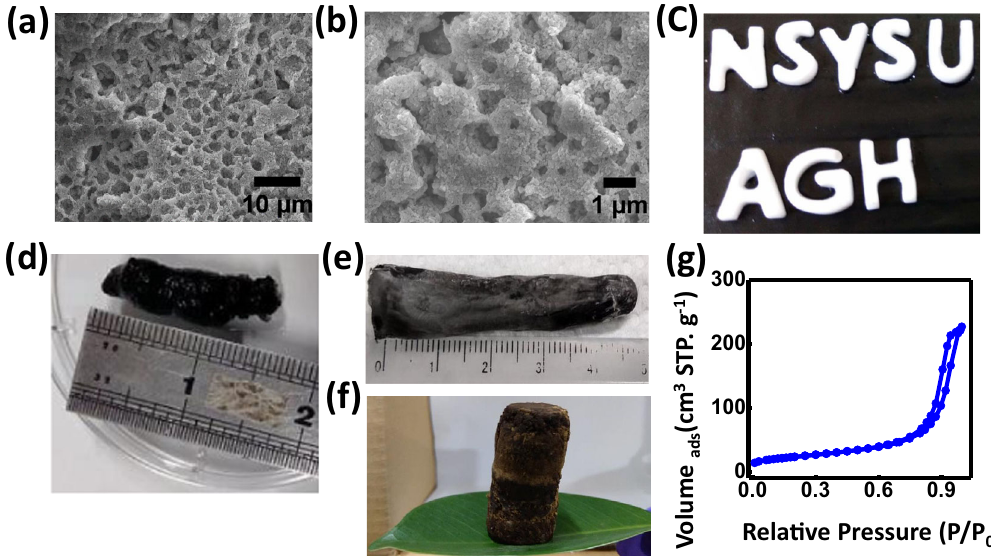
Fig. 4 Adsorbent porosity behaviors. Characterization of the h -BN-related aerogels. a , b SEM images of the MHAs. Photographs of ( c ) the PEI- h -BNNSs-loaded PVA aerogels with a shape of “ NSYSU ” and “ AGH ” , ( d ) the Fe 3 O 4 NP-loaded PVA aerogel (25 mg mL − 1 ), ( e ) the MHAs with a volume of (30 mg mL − 1 ), and ( f ) the MHAs with a volume of (45 mg mL − 1 ) standing on a leaf. g BET adsorption isotherm of the